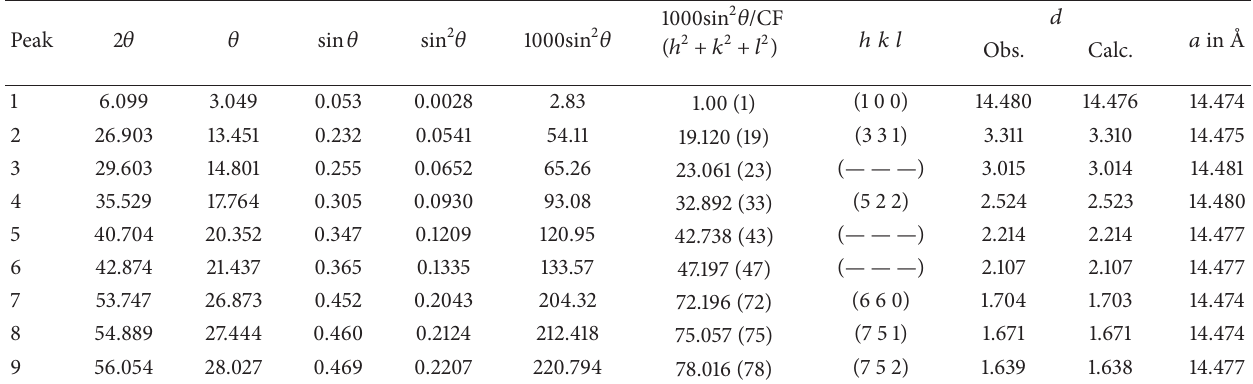
Table 6: Powder X-ray data of Ni(II)